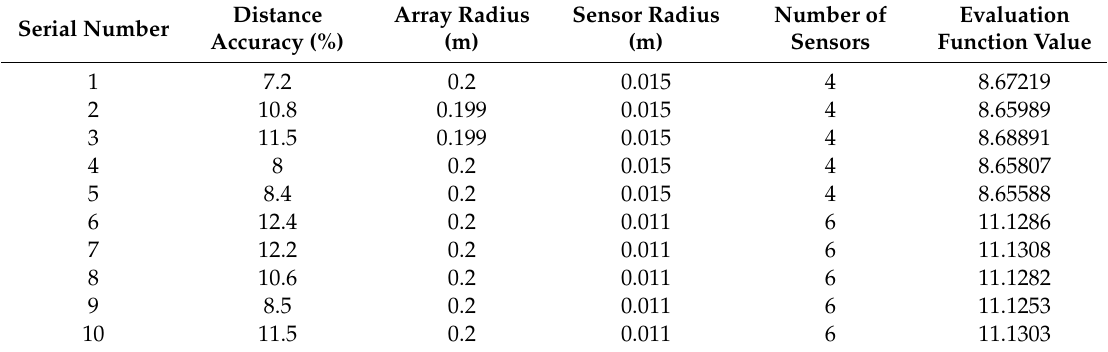
Table 4. Optimization results.